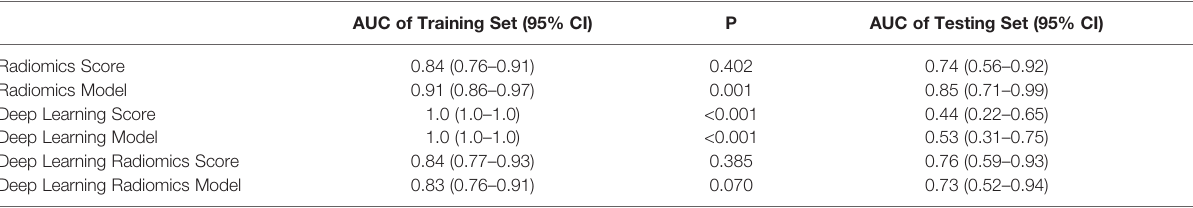
TABLE 2 | Summary of the performance of different radiomics scores.